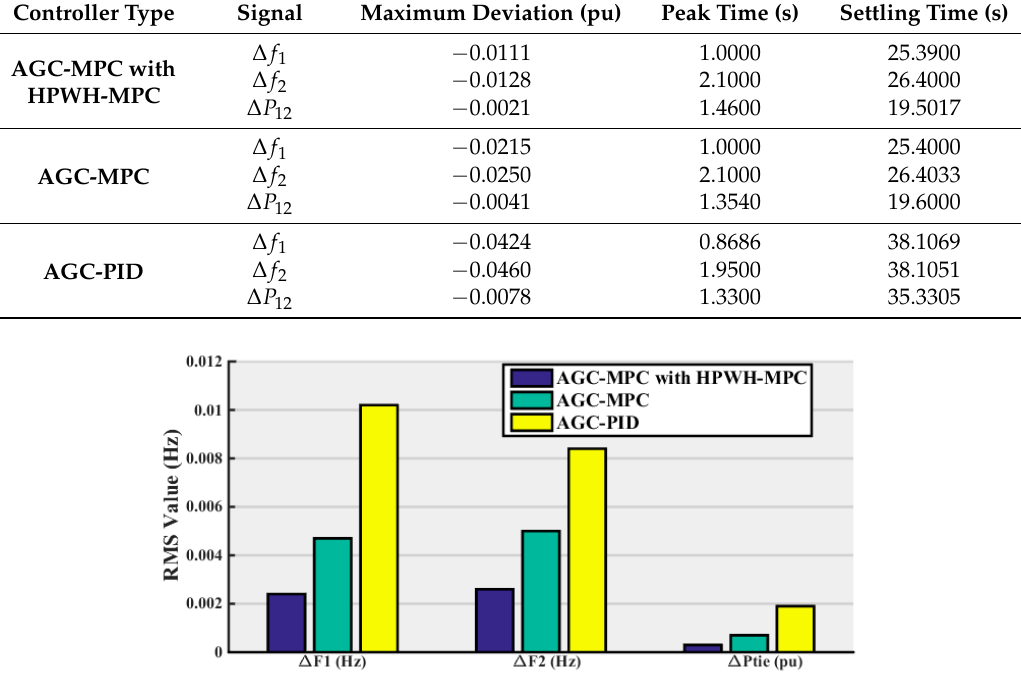
Figure 13. RMS value of deviations for Scenario 3.